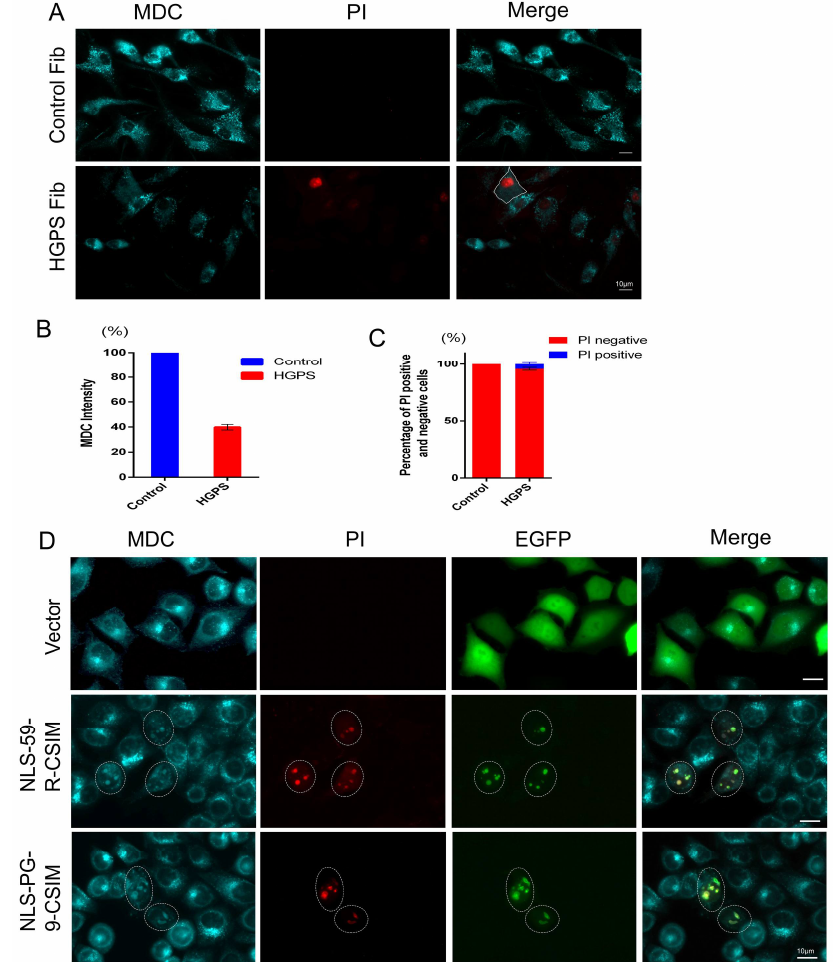
Figure 6. Determination of autophagy activity. ( A ) Monodansylcadaverine (MDC) and propidium iodide (PI) staining were performed to detect the numbers of autophagosomes and dead cells in normal and HGPS fibroblasts. Representative images of cells are shown. HGPS cells exhibit heterogeneous brightness of MDC fluorescence intensity. A PI-positive cell with no detectable MDC signal is outlined. ( B ) The fluorescence intensity of MDC was measured in control and HGPS fibroblasts. Two hundred fifty-three control cells and 244 HGPS cells were counted. The average MDC fluorescence intensity was used for the statistical analysis. ( C ) The percentages of PI-positive cells were calculated by counting 317 control cells and 309 HGPS fibroblasts. All statistical analyses were performed using Student’s t -test. Two-tailed p -values were calculated and p < 0.05 was considered significant. ( D ) MDC and PI staining in EGFP vector-, EGFP–NLS-59-R-CSIM-, and EGFP–NLS-PG-9-CSIM-transfected cells. EGFP–NLS-59-R-CSIM- and EGFP–NLS-PG-9-CSIM-transfected cells showing colocalization of MDC with the EGFP signal at the NE invaginations are circled. Scale bar, 10 μm.